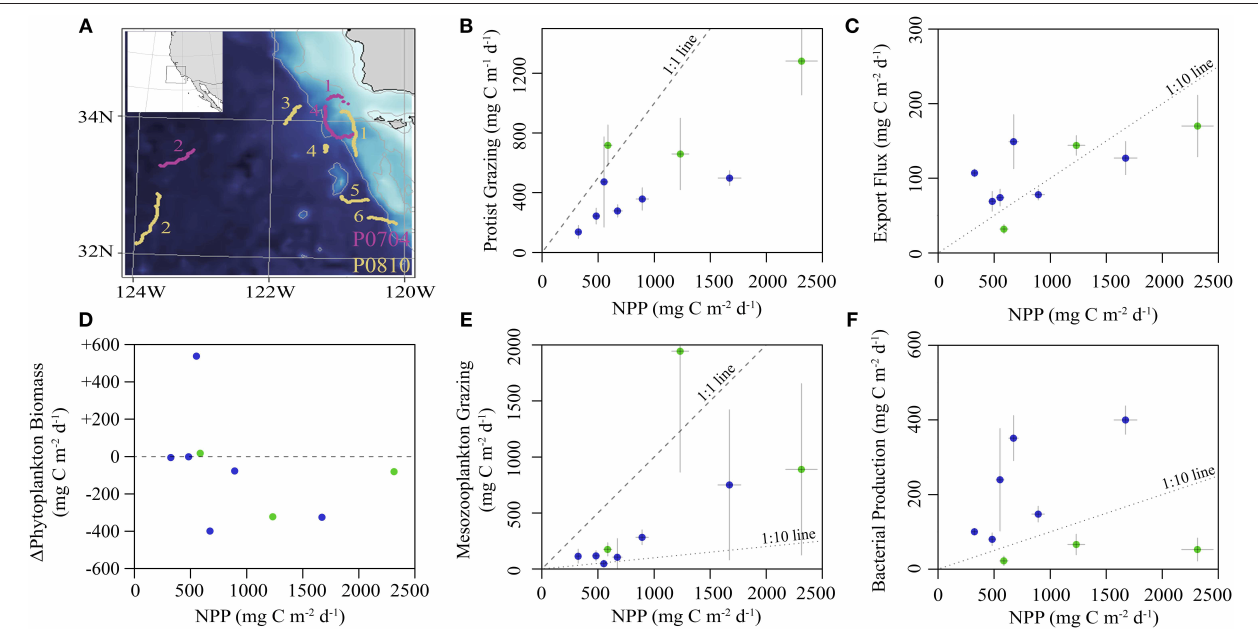
FIGURE 2 | (A) Bathymetric map of study region showing drift trajectories from each cycle (inset shows larger region). Numbers correspond to cycle for P0704 (purple) and P0810 (yellow). (B–F) Summary of in situ observations plotted against NPP: (B) protistan grazing, (C) export flux from sediment trap at 100m, (D) observed rate of change of phytoplankton biomass, (E) mean mesozooplankton grazing, and (F) epipelagic bacterial production. Values are colored by cruise (P0704 = green, P0810 = blue). Dashed lines for reference slopes of 1:1, 1:10, or no change as indicated and error bars are ± 1